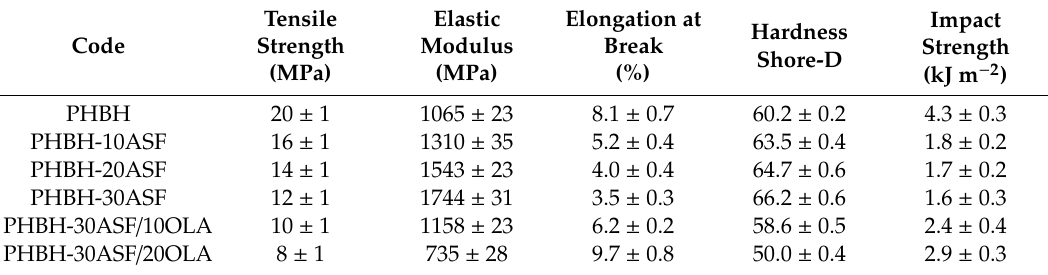
Table 2. Summary of the mechanical properties of the PHBH-ASF / OLA composites with di ff erent compositions, in terms of the tensile modulus ( E t ), maximum tensile strength ( σ max ), elongation at break ( ε b ), Shore-D hardness and impact